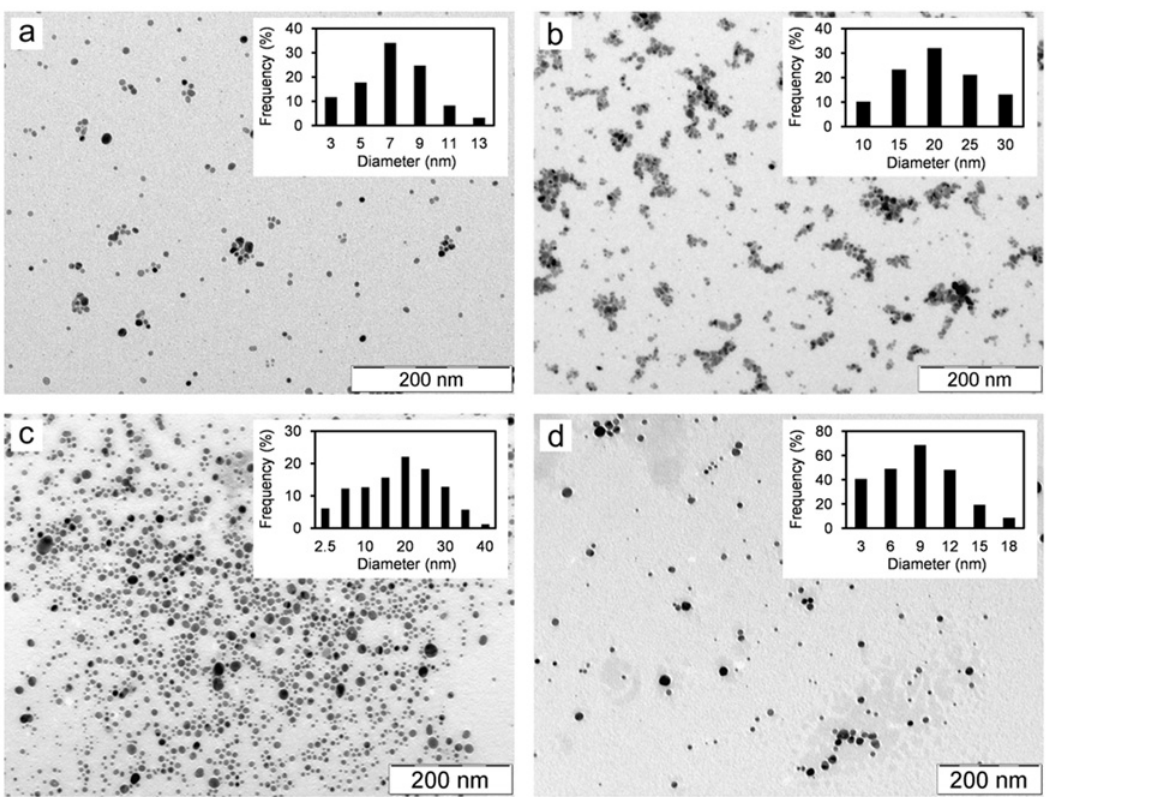
Fig 2. TEM images and distribution diagrams of Ag NPs prepared in the presence of a) PEG, b) PVP, c) PVA and d)